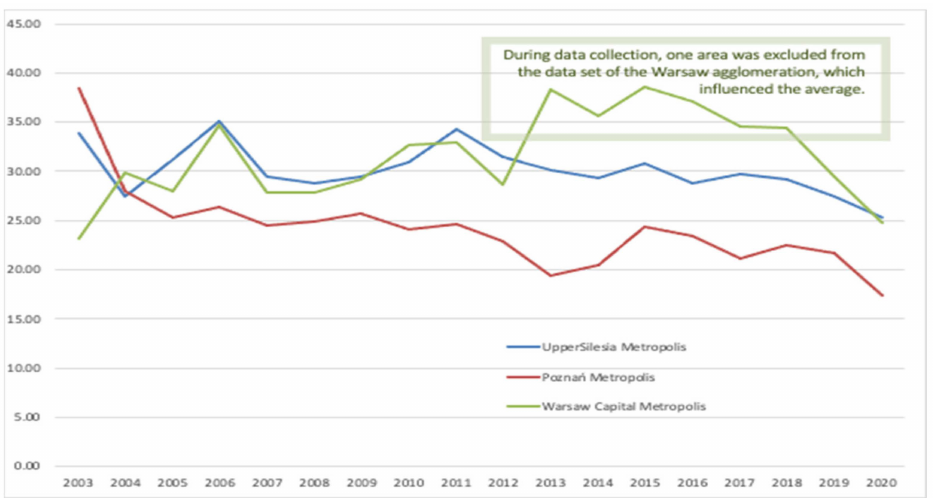
Figure 7. The results of NOx measurements in three metropolises in Poland in the period from 2003 to 2020. Source: Own elaboration based on measurements [109].